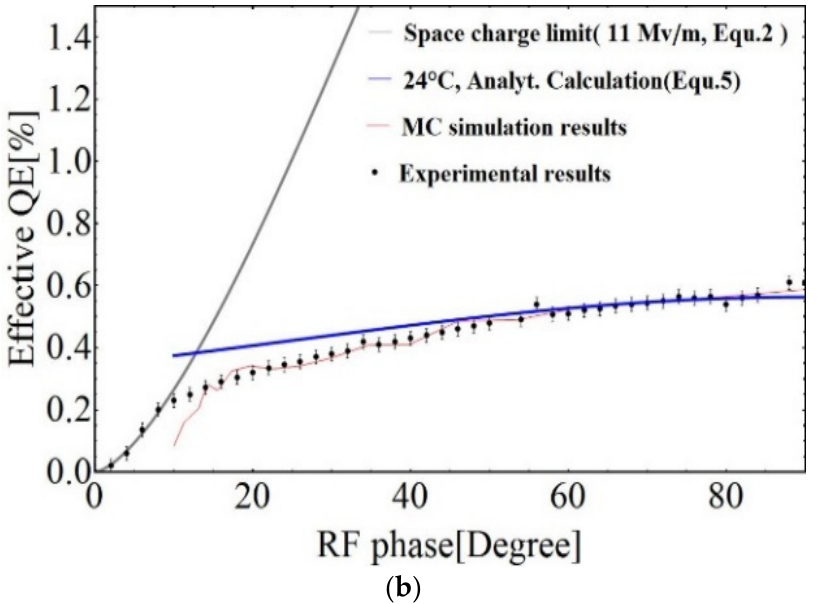
Figure 11. ( a ) The simulation results of spectral response with and without electron–hole (e–h) scattering, and intrinsic emittance at room temperature. The dots are the experimental results of the spectral response of the K 2 CsSb photocathode at room temperature [55]. ( b ) The Schottky effect on the cryo-cooled K 2 CsSb photocathode in the 704 MHz SRF gun at Brookhaven National Lab (BNL) [68]. Reproduced with the permission from reference [68] .